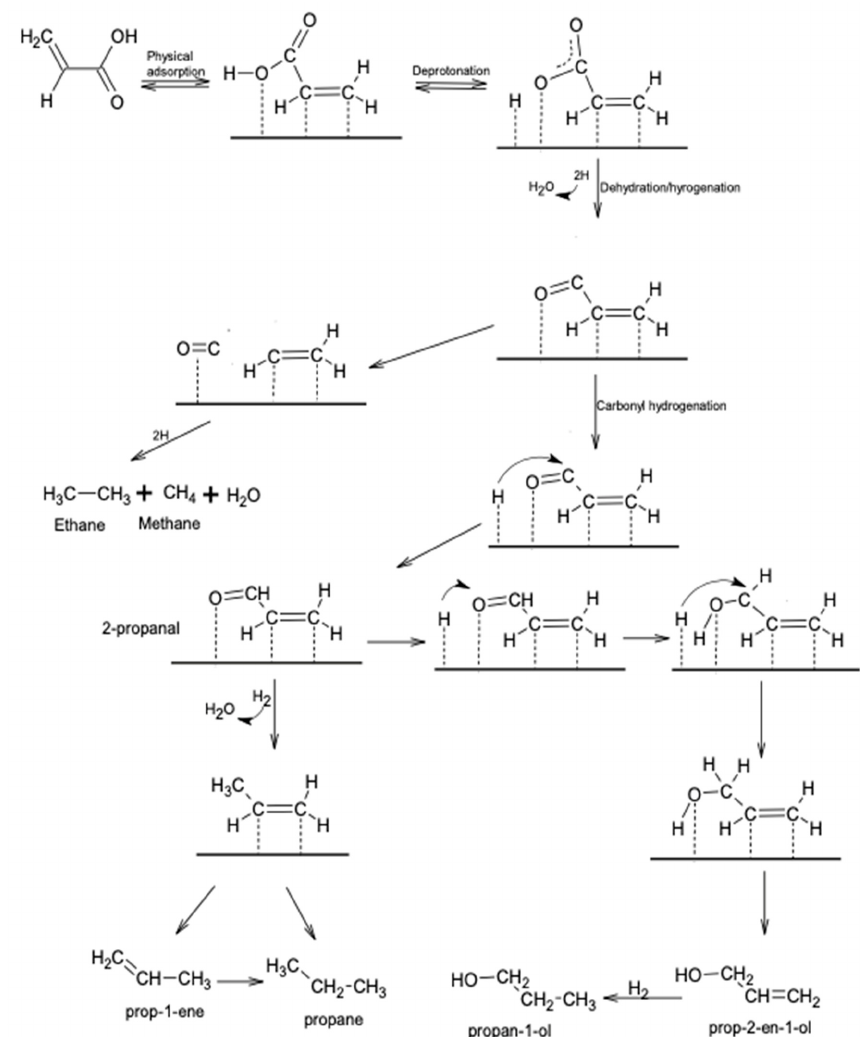
Figure 12. Reaction mechanism for the HDO of acrylic acid. Reproduced from reference [88].